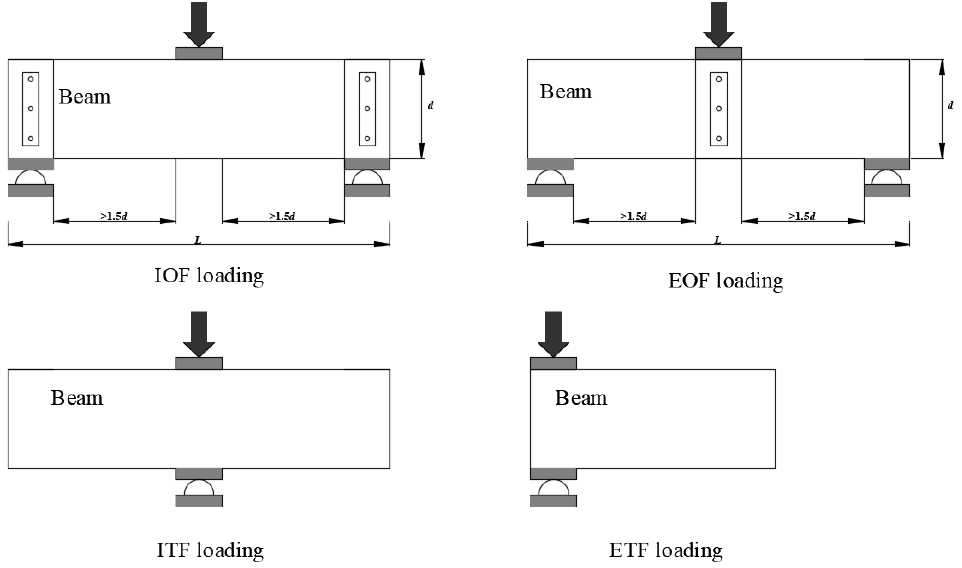
Figure 1. Web crippling failure at a reaction point.